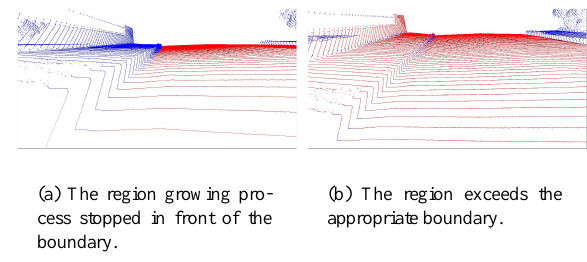
(a) The region growing pro- cess stopped in front of the boundary. Figure 4: Examples of road detection by the point-based region growing. The detected road points are colored in red.